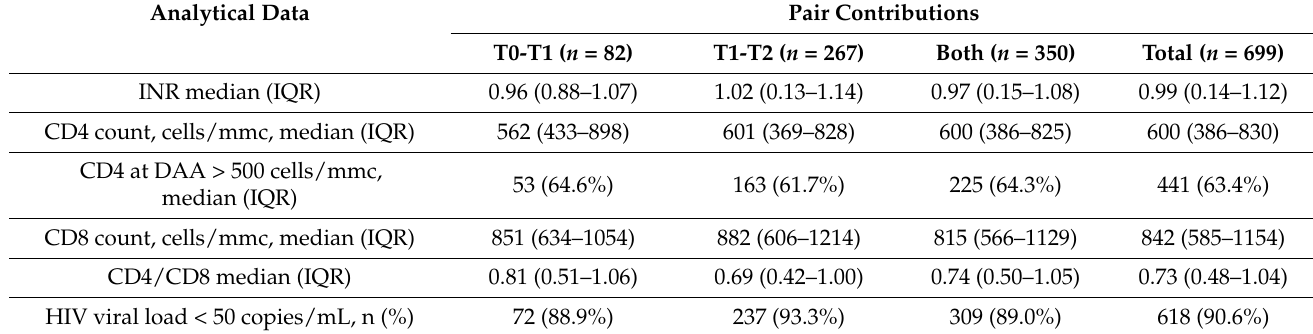
Table 2. Cont. Analytical